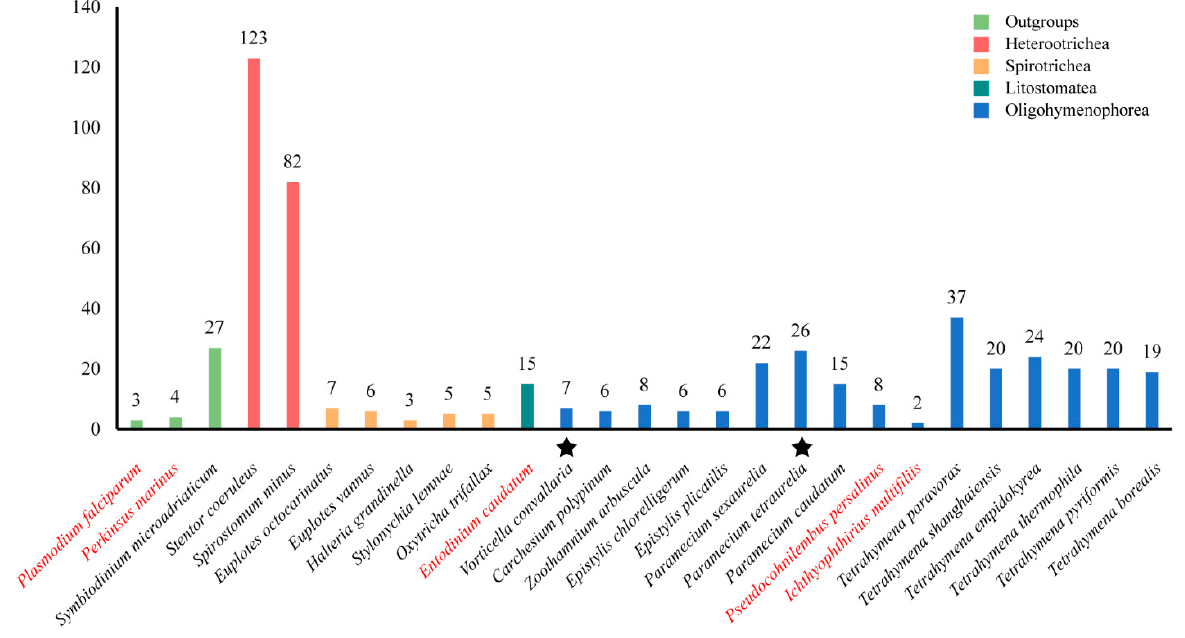
Figure 1. The number of GPCRs in 24 ciliates and three outgroups. Different colors represent different species. Red: parasitic and symbiotic species; black: free-living species. Stars indicate that the species have been shown to undergo genome duplication.